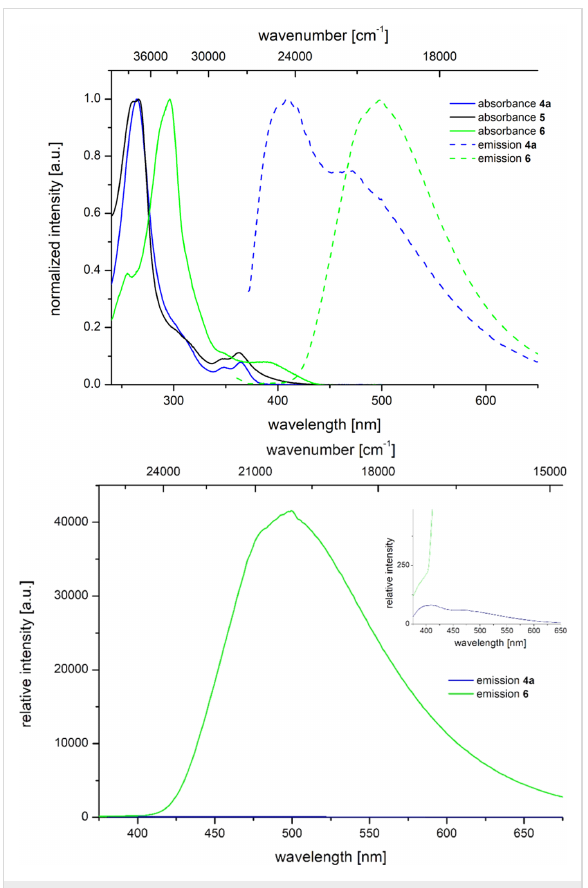
Figure 8: Relative emission intensities of the 1-phenyl-2,3-naph- thaleneimide 4a (blue) and the pentacyclus 6 (green, normalized on the absorptivity at the excitation wavelength λ exc = 350